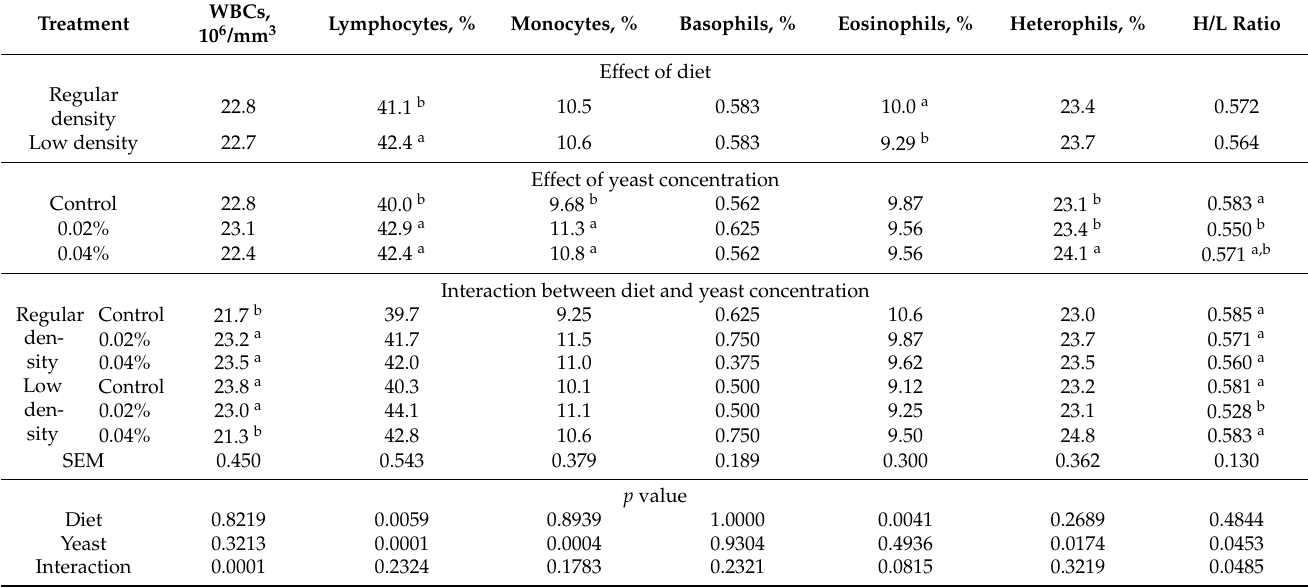
Table 5. Impact of different concentrations of Saccharomyces cerevisiae on white blood cells (WBC) and its subpopulations in broilers fed regular- and low-density diets from 1 to 38 days of